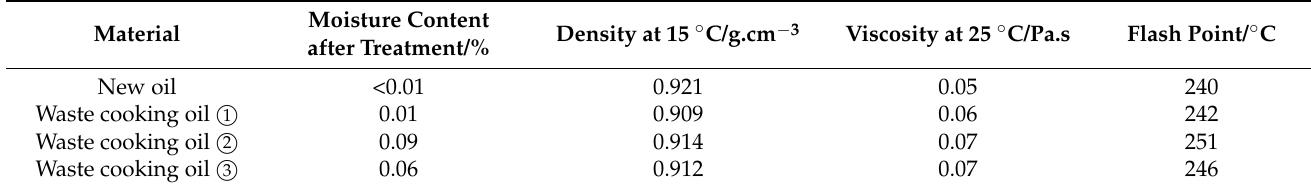
Table 12. Physical property of new oil and waste cooking oil [69].